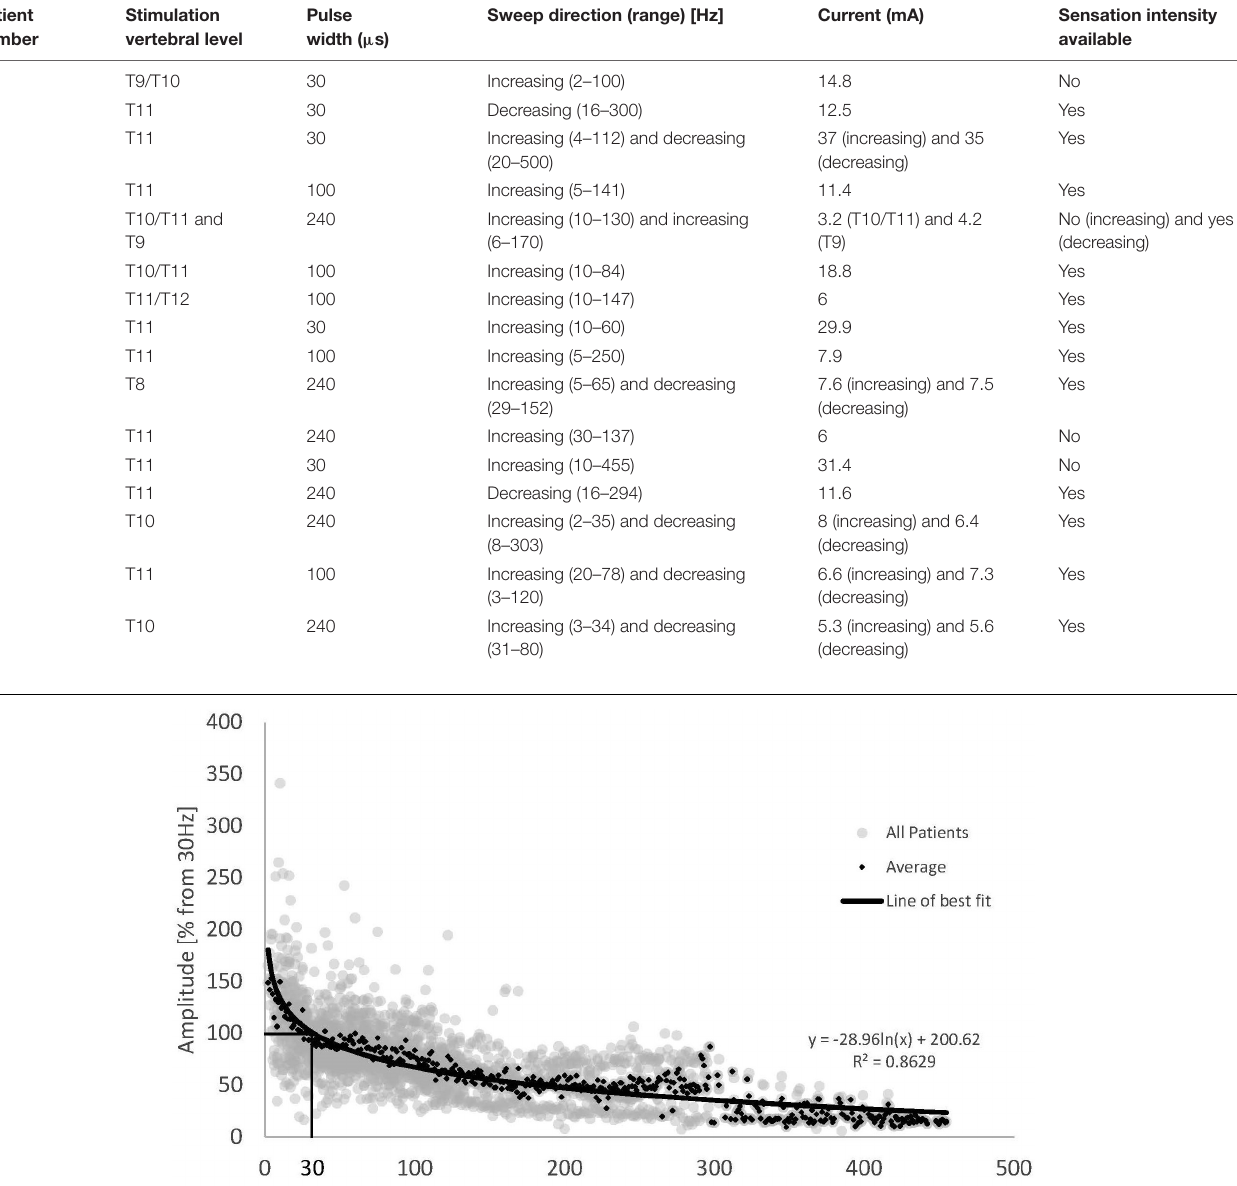
TABLE 1 | List of patients with available data.